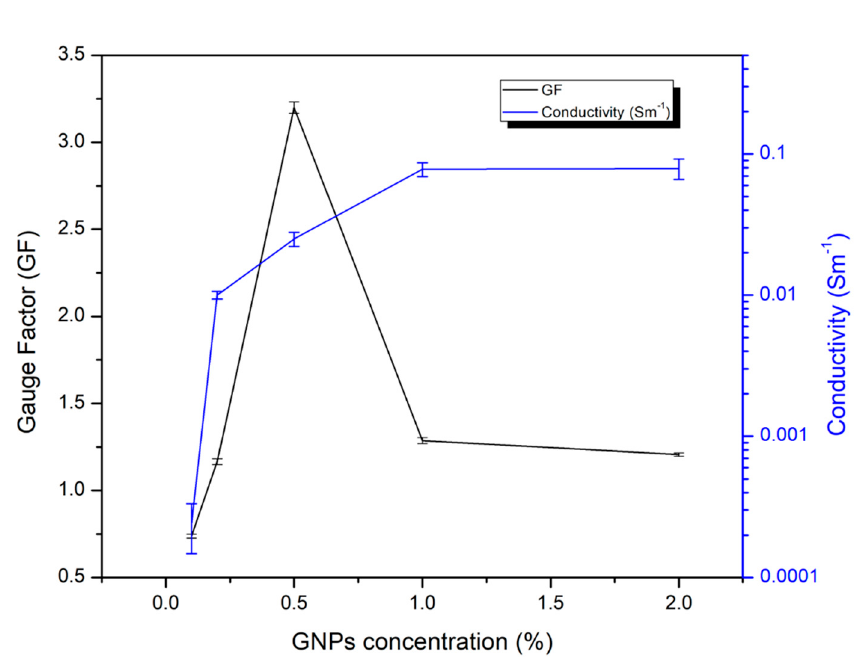
Figure 11. Electrical conductivity and GF in relation to the GNPs concentration.